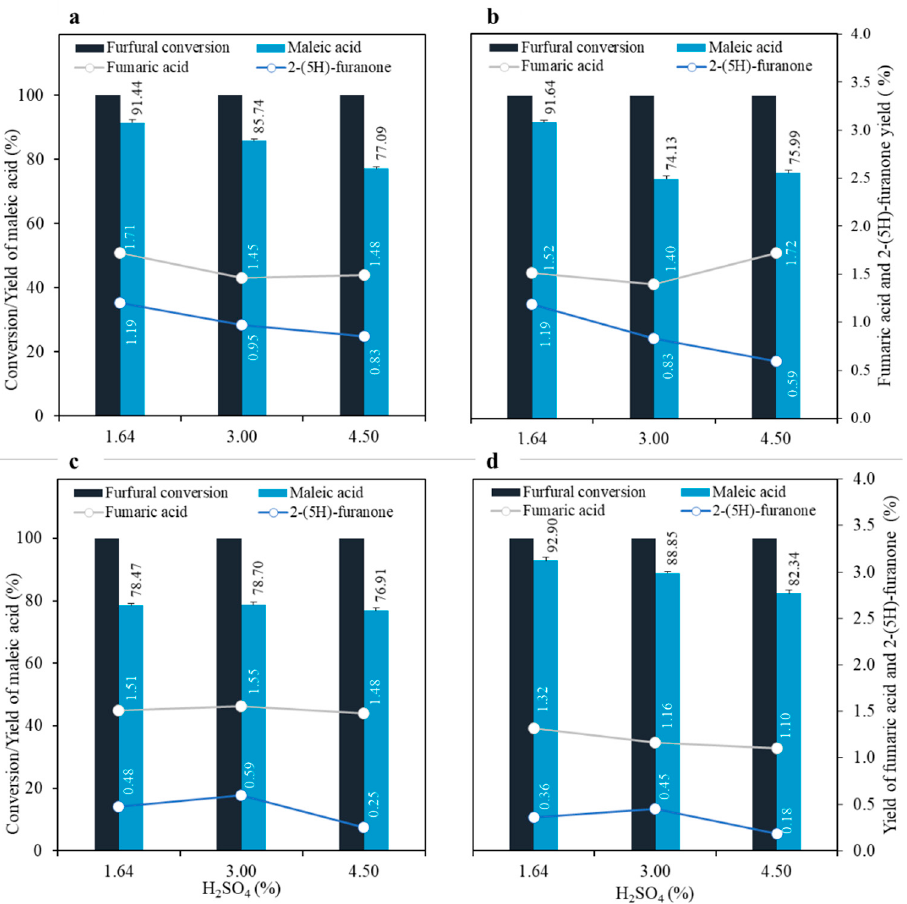
Figure 5. Maleic acid produced from furfural in the second hydrolysate using formic acid (4 mL) and H 2 O 2 (1 mL), depending on combined severity factors (CSFs) and H 2 SO 4 concentration ( a ) CSF 1.89, ( b ) CSF 1.92, ( c ) CSF 2.08, ( d ) CSF: 2.29.